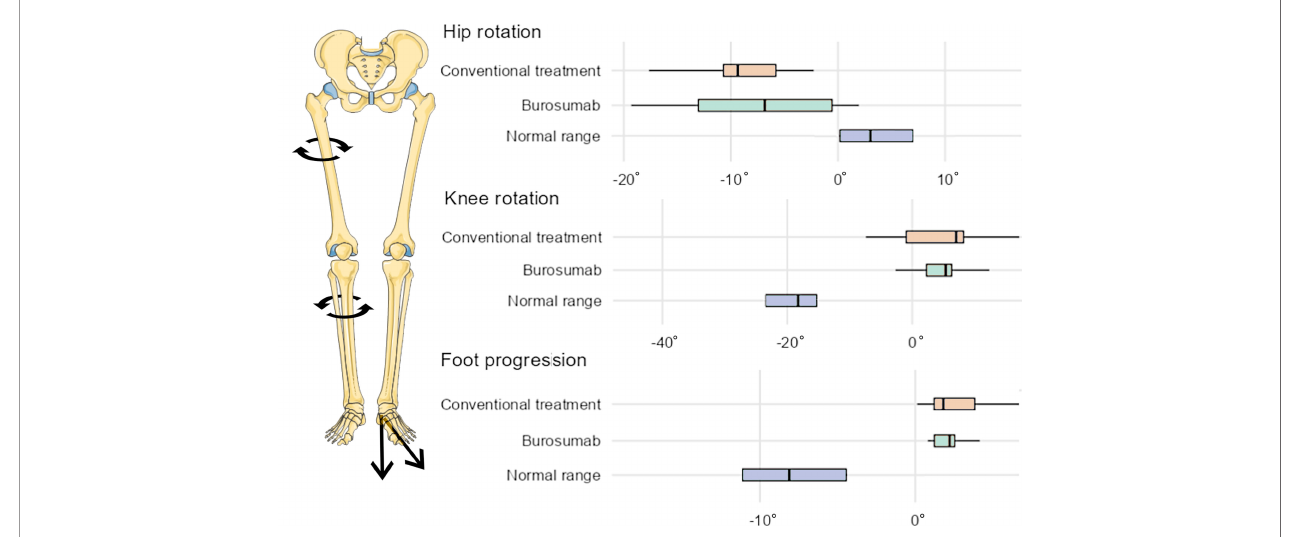
FIGURE 3 | Box chart comparison of gait analysis data (mean rotation during stance) under conventional treatment (orange) and one year after switch to Burosumab treatment (green). X-axis indicates degrees, boxes show median values, upper and lower quartiles. Negative values represent external rotation, positive values internal rotation. Blue boxes represent reference ranges of healthy pediatric controls (Adapted from Servier Medical Art by Servier under a Creative Commons Attribution 3.0 Unported License).